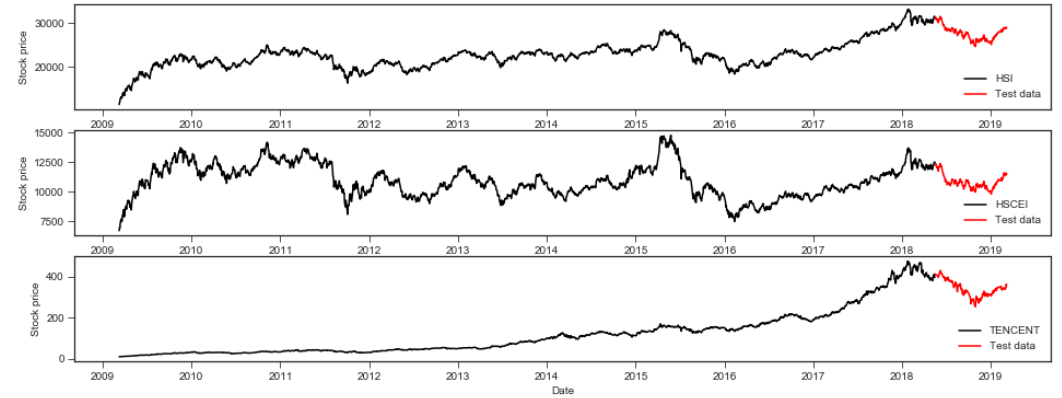
Figure 1. Plots showing the daily close prices between March 9, 2009 and March 8, 2019.